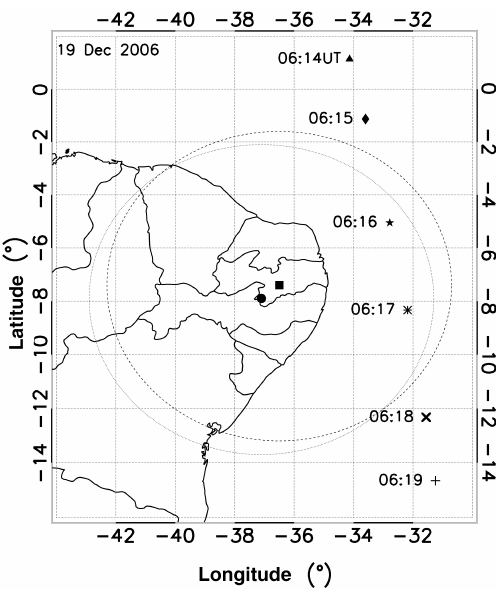
Figure 2. Observation sites (filled square São João do Cariri; filled circle Monteiro) and the field of view of the imagers (dashed line circle São João do Cariri; dotted line circle Monteiro). Six sound- ings of the TIMED/SABER satellite are shown as well (triangle at 06:14UT, diamond at 06:15, star at 06:16, asterisk at 06:17, big X at 06:18 and a plus at 06:19).